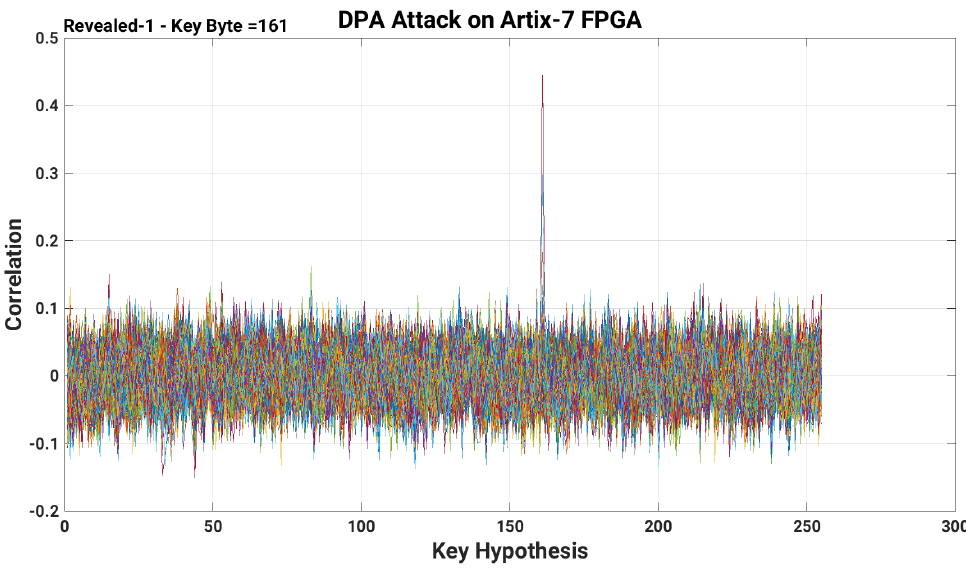
Figure 4. Retrieval of first-byte of a 128-bit secret key obtained after the execution of a DPA attack on DESIGN-I (AES without our proposed countermeasure).